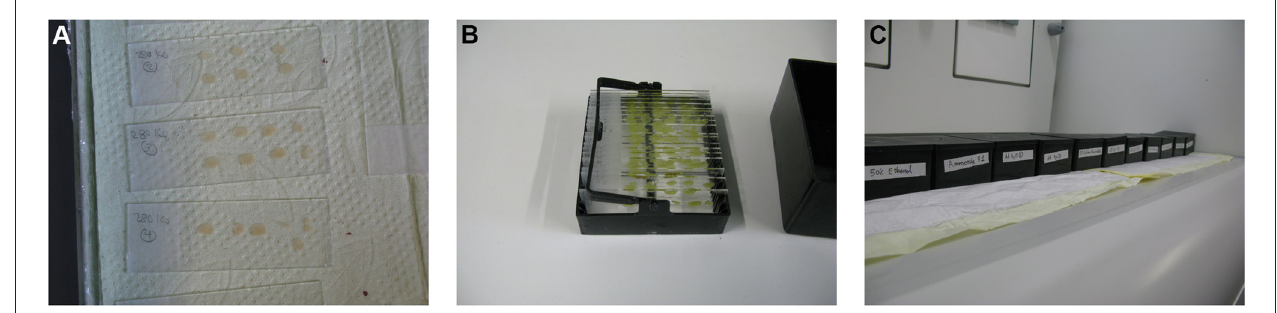
FIGURE 4 | Developing step . After drying the sections, they are transferred to staining racks (A,B) and developed as described in the manuscript text (C) .